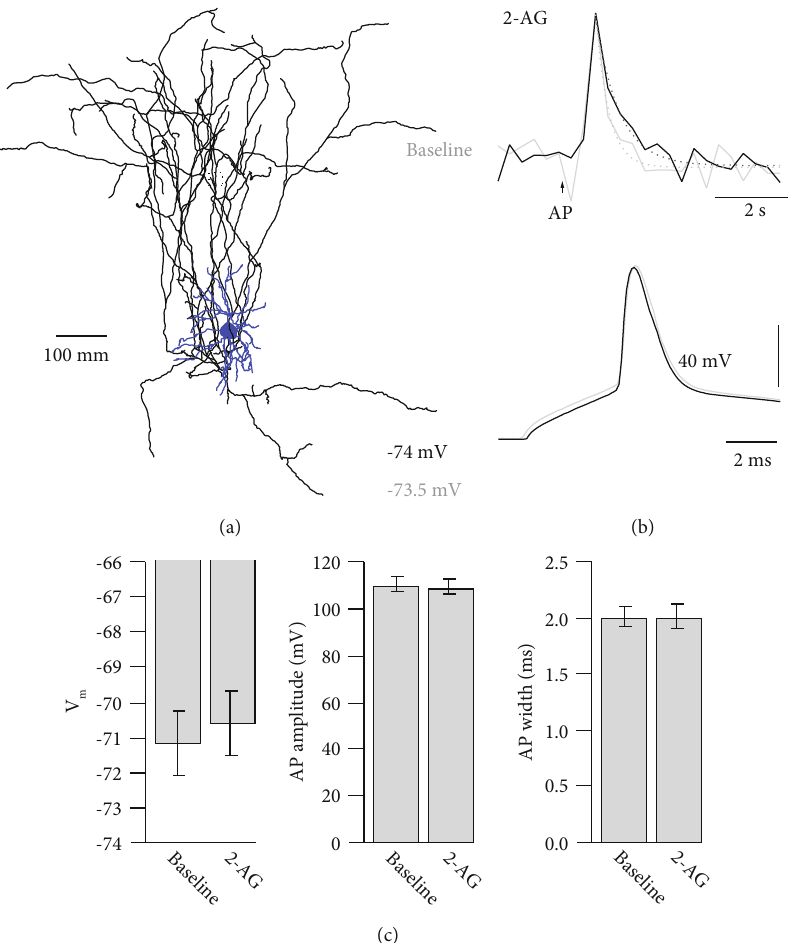
Figure 6: AP properties are una ff ected by 2-AG. (a) Neurolucida reconstruction of a spiny stellate neuron. Dendrites are represented in blue and the axonal arborization in black. (b) Upper traces, averaged and normalized AP-evoked Ca 2+ transients during baseline (grey) and after bath application of 2-AG (black). Dashed lines represent single exponential fi ts to the decay of the Ca 2+ transients. Lower traces, corresponding somatic APs before (grey) and after (black) bath application of 2-AG. (c) Average bar graphs of resting membrane potential, AP amplitude, and AP width before and after bath application of 2-AG ( n = 12 ). None of the parameters changed signi fi cantly ( p > 0 : 1 by paired Student ’ s t -test). All data are represented as mean ± SEM